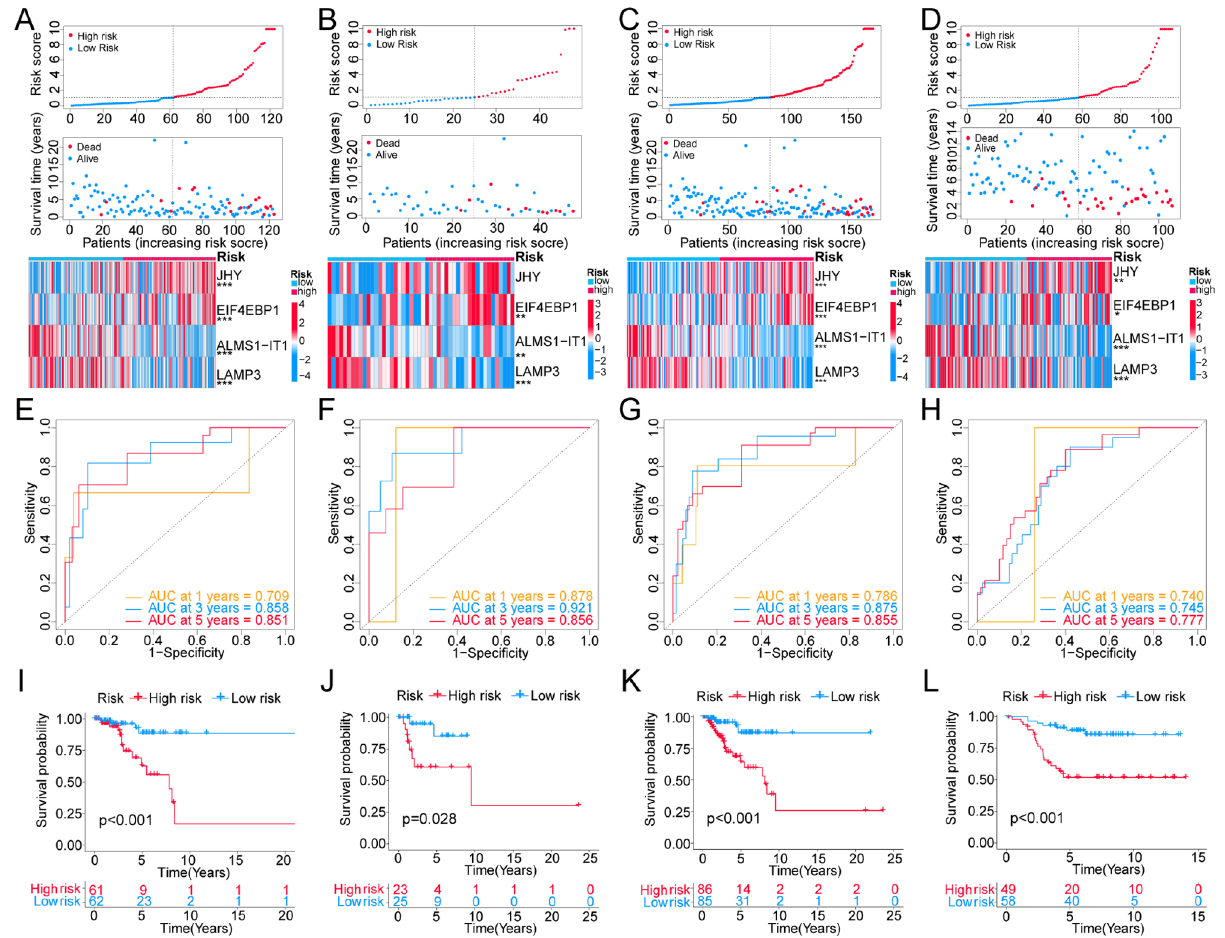
Figure 5. Evaluation of the Lasso–Cox model in four data sets. ( A – D ) The risk stratification diagram (including risk status map, risk point map and risk heat map) showed that patients in the high-risk group had worse overall survival (OS) in internal training set ( A ), internal validation set ( B ), entire TCGA-TNBC cohort ( C ) and GSE58812 cohort ( D ). ( E – H ) Time dependent ROC analysis of Lasso–Cox model in internal training set ( E ), internal validation set ( F ), entire TCGA-TNBC cohort ( G ) and GSE58812 cohort ( H ). ( I – L ) Kaplan– Meier survival analysis of Lasso–Cox model in internal training set ( I ), internal validation set ( J ), entire TCGA- TNBC cohort ( K ) and GSE58812 cohort ( L ). * P < 0.05; ** P < 0.01; *** P <